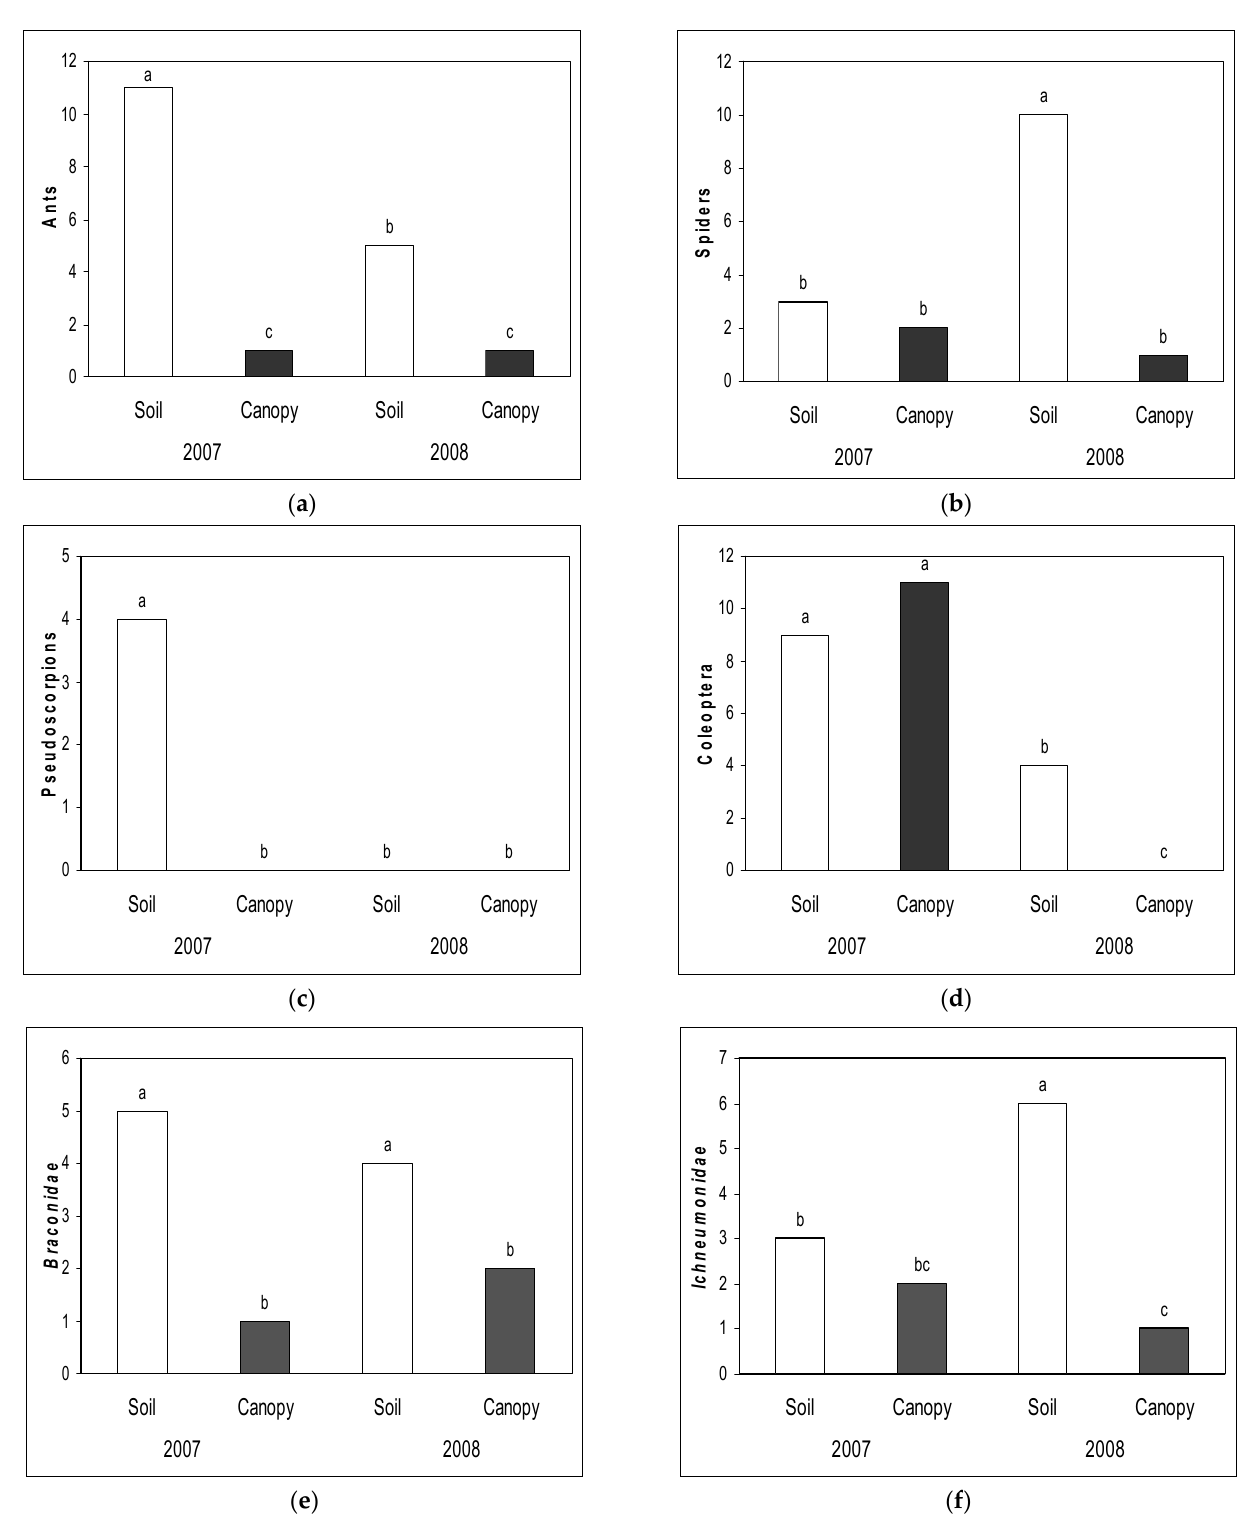
Figure 3. Effect of year and sampling position (soil = above the soil, within the cover crop canopy; canopy = within the olive tree canopy) on the activity of ( a ) Formicidae (ants), ( b ) Araneae (spiders), ( c ) Pseudoscorpiones (pseudoscorpions), ( d ) Coleoptera (beetles) and the parasitic wasp families ( e ) Braconidae and ( f ) Ichneumonidae. Values shown are interaction means ± SE (see Tables 1 and 2 for the p values of the year x sampling position interactions). Bars with the same letter within each figure are not significantly different according to THSD tests ( p < 0.05).